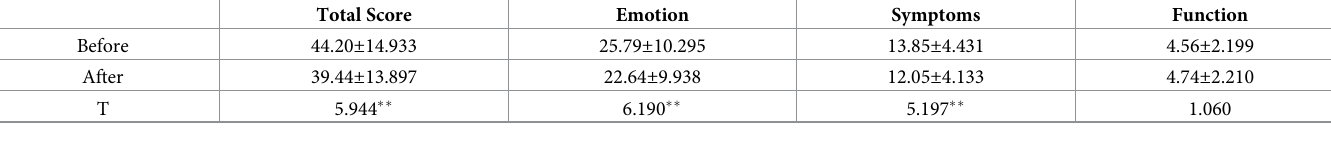
Table 9. Scores on the adjusted RosQol before and after treatment ( (cid:22) x ±S, n = 117).